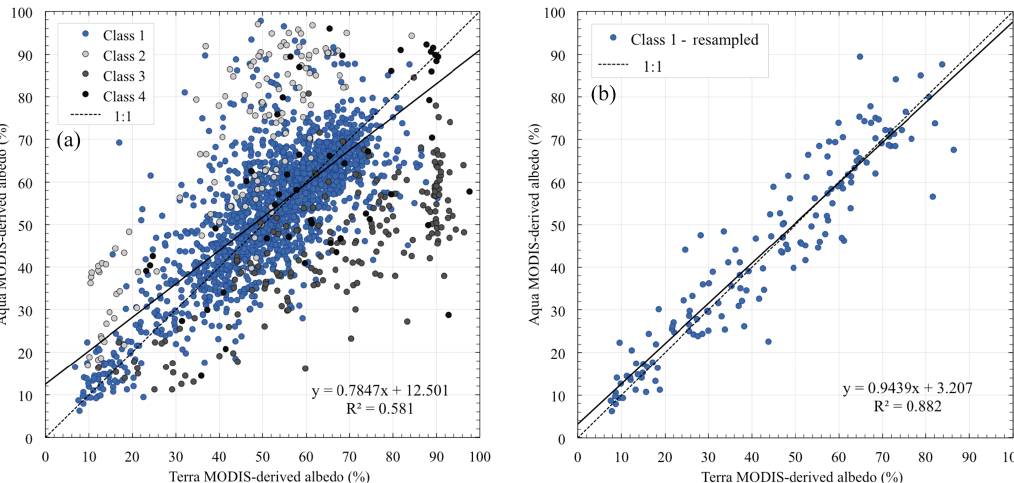
Figure 12. Pixel-by-pixel comparison of MODIS-derived glacier surface albedo across the GoEA, from four pairs of cloud-free Terra and Aqua MODIS images (4 March 2009, 10 March 2010, 9 March 2012, 11 March 2013). Linear regression analysis was performed on (a) all Class 1 pixels ( R 2 = 0 . 58, p < 0 . 001) and (b) a stratified random sample of 150 Class 1 pixels ( R 2 = 0 . 88, p < 0 . 001). The dotted line represents the ideal 1 : 1 relationship.